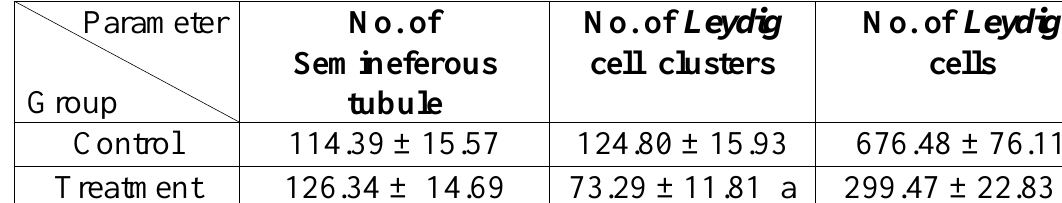
Table 2 : Number of semineferous tubules, Leydig cell clusters and Leydig cells in histological section of control and Gossypol treatment groups (40)mg/kg BW for (42)